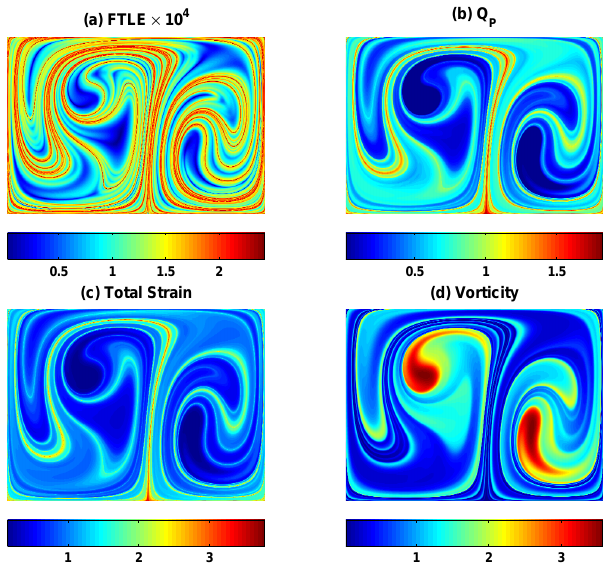
Fig. 1. Finite-time Lyapunov exponent σ and Okubo–Weiss Q P fields (upper left and right images, respectively). The total strain s 2 = s 2 n + s 2 s and vorticity ω 2 fields are shown below (left and right images, respectively). Except for the FTLE field, the rest of the magnitudes were integrated along the Lagrangian path followed by tracer particles during the integration time τ = 3 T . Set of parame- ters: A = 0 . 1, (cid:15) = 0 . 2, T = 10 and ω = 2 π/T .